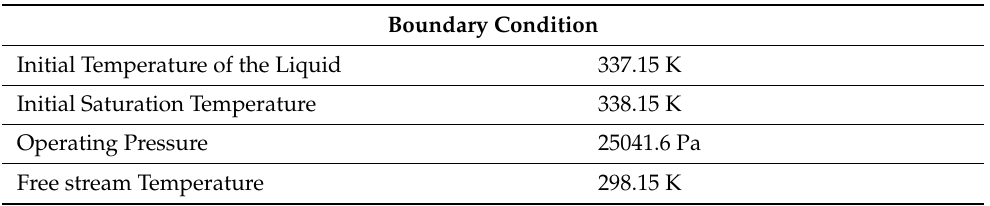
Table 2. Boundary Conditions of the CFD Simulation.